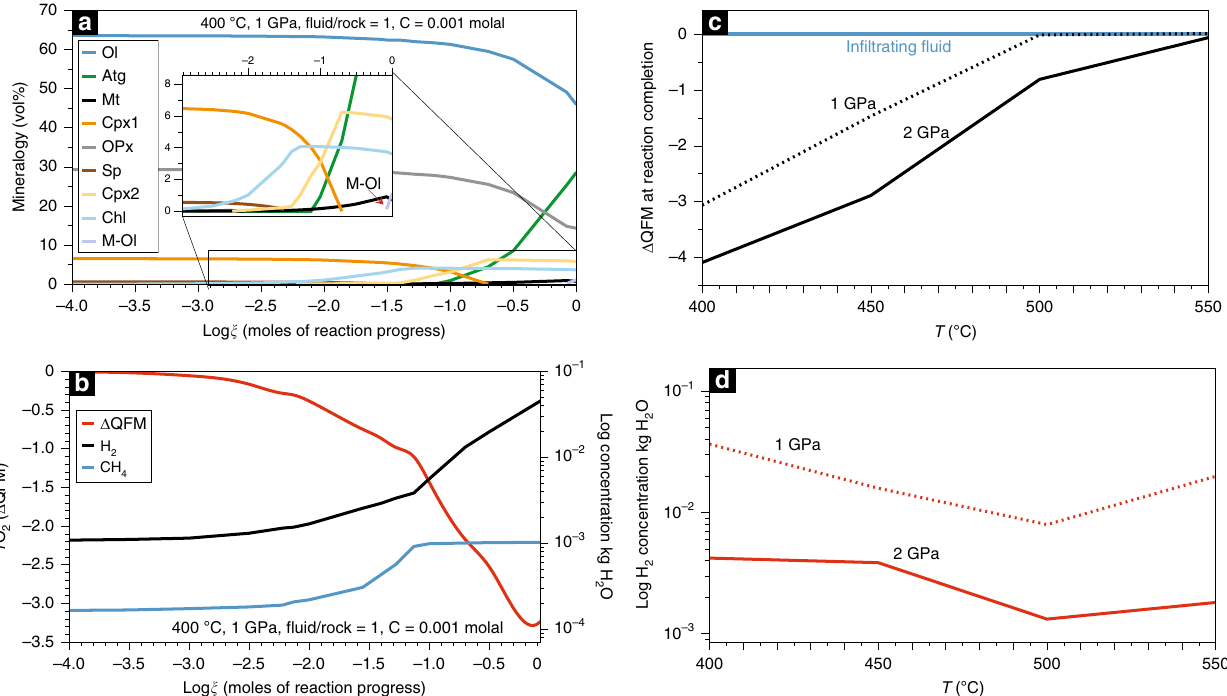
Fig. 4 Thermodynamic modelling of high-pressure serpentinization of harzburgite and related redox evolution and H 2 concentrations. a Mineralogical evolution during high-pressure serpentinization at 400°C and 1 GPa. b Evolution of the f O 2 and the H 2 and CH 4 concentrations in the fl uid as a function of the reaction progress for the model presented in a . c Oxygen fugacity (as Δ Log relative to the QFM buffer — Δ QFM — ) for the fl uid in equilibrium with either a pre-existing serpentinite at QFM (in fi ltrating fl uid in the models, e.g., from a subducted oceanic serpentinite) and a serpentinite formed through high-pressure serpentinization at different P and T . d H 2 concentration at reaction completion for different P and T conditions. The x -axis represents the log of the reaction progress which is equal to the number of moles of each reactant mineral destroyed per kg of H 2 O. Mineral abbreviations as in Fig. 1 except for Cpx1 mantle clinopyroxene, Opx mantle orthopyroxene, Sp mantle spinel, Cpx2 metamorphic clinopyroxene, Chl